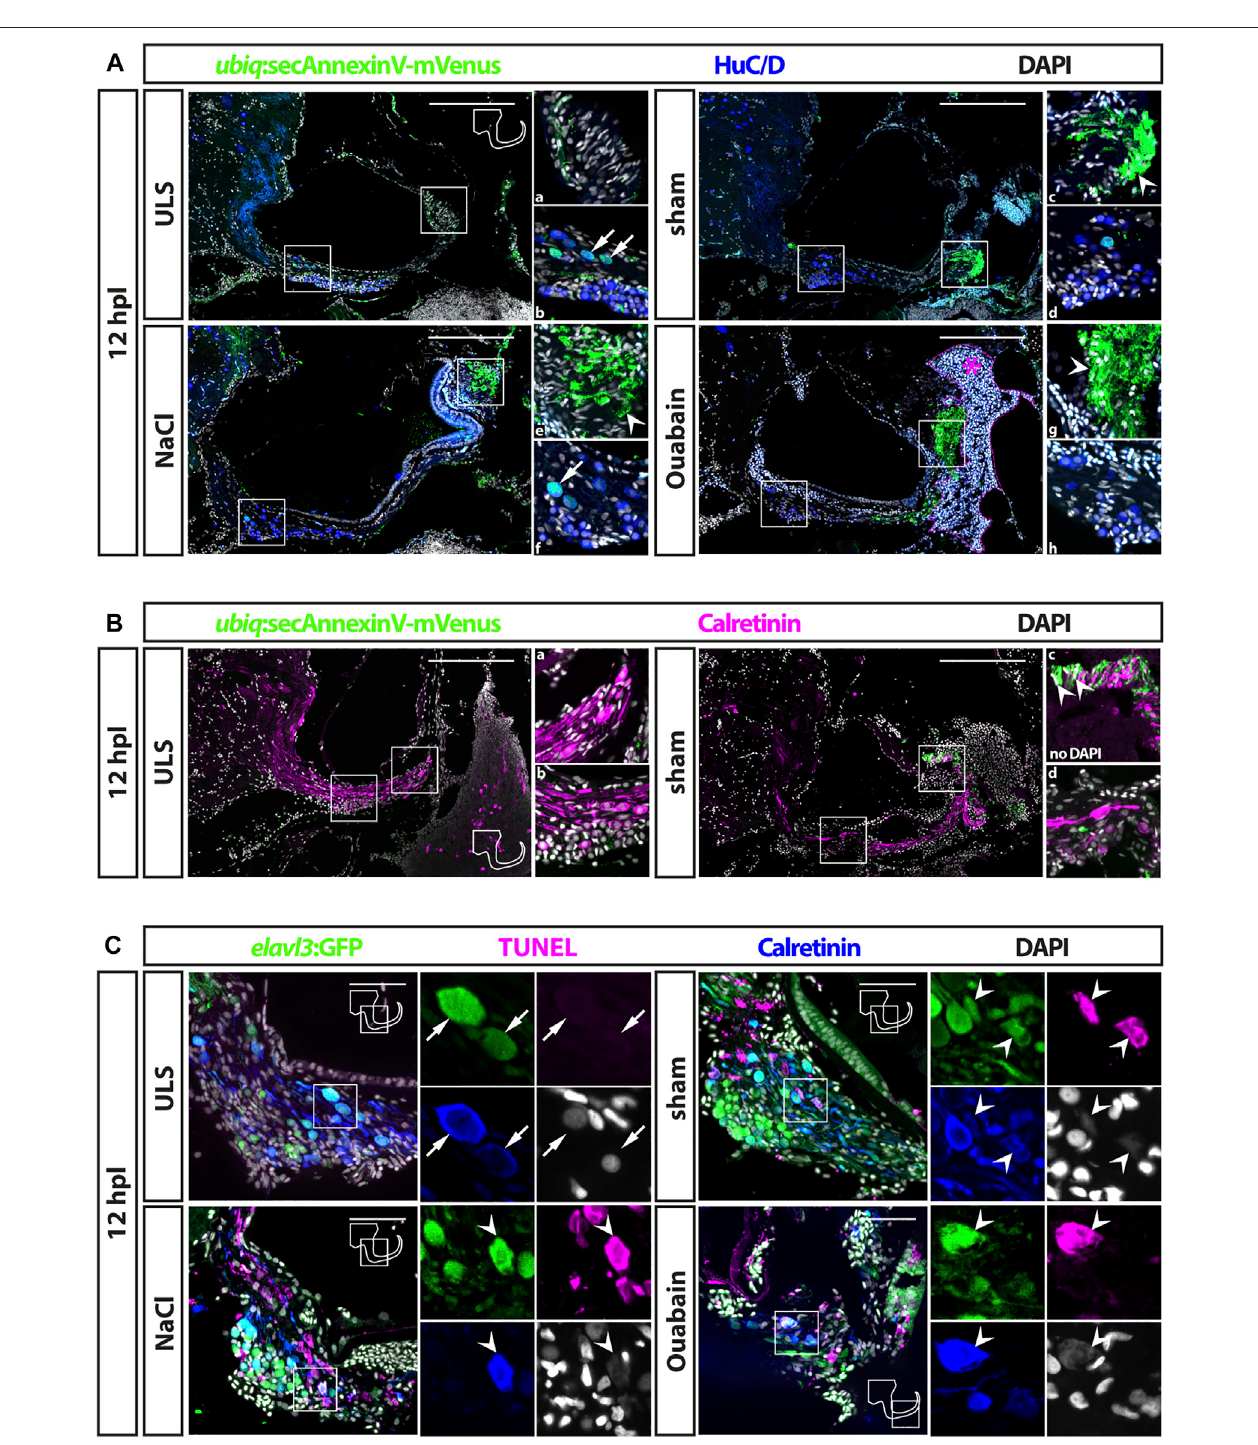
FIGURE 2 | Cell death in the adult zebra fi sh SAG upon lesion. (A) Antibody staining of the adult zebra fi sh SAG labeling ubiq: secAnnexinV-mVenus-positive cells andHuC/D-positiveneurons.Incontrasttounlesionedsides(ULS),astrong ubiq: secAnnexinV-mVenus-signalwaspresentintheSAGfollowingshamtreatmentorNaCl and Ouabain injections at 12 h post lesion (hpl). In the medial part of the SAG, which harbors the neurogenic niche and the neuronal cell bodies, only very few HuC/ D-positivecellsshowedaweak ubiq: secAnnexinV-mVenusstaininginallsamples(arrowsinbandf).InthedistalpartoftheSAG,wheretheneuritesofthesensory neurons innervate the sensory patch, a strong ubiq: secAnnexinV-mVenus staining was observed in sham-treated as well as NaCl- and ouabain-injected SAGs, but almost no signal was detected in unlesioned control sides (arrowheads in c, e, and g). Magenta dotted line and asterisk in ouabain-injected SAG indicates a massive